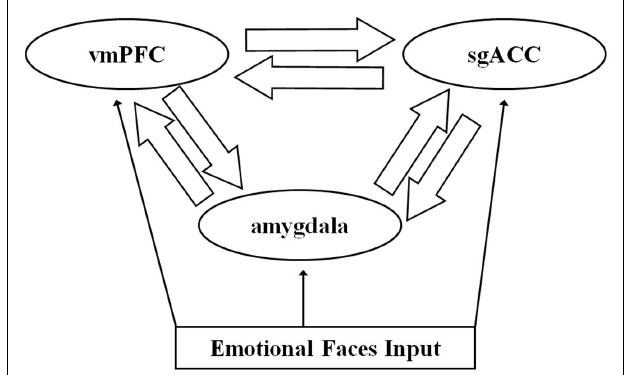
FIGURE 1 | Graphic representation of a single happy trial of our emotional dynamic faces task. Over a 1-s duration, the face changed from neutral (0% emotion) to a happy, sad, angry, or fearful face (100% emotion). Participants were asked to identify the color flash presented in mid dynamic change.